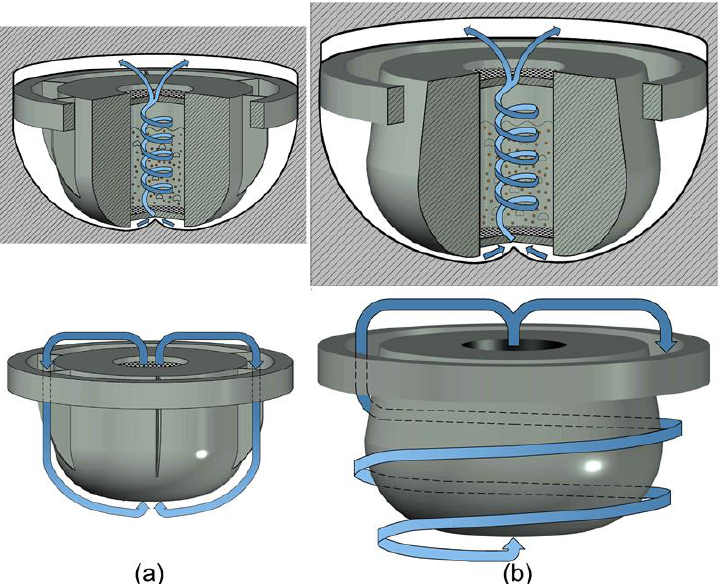
Figure 8. ( a ) The 1992-CREC Riser Simulator with its Cylindrical Shaped Basket and Vertical Baffles, promoting axial outer basket downflow and circumferential inner basket upflow, ( b ) The 2019- CREC Riser Simulator with its Frustoconical Shaped Basket without Vertical Baffles, promoting circumferential inner basket upflow and circumferential outer basket downflow.